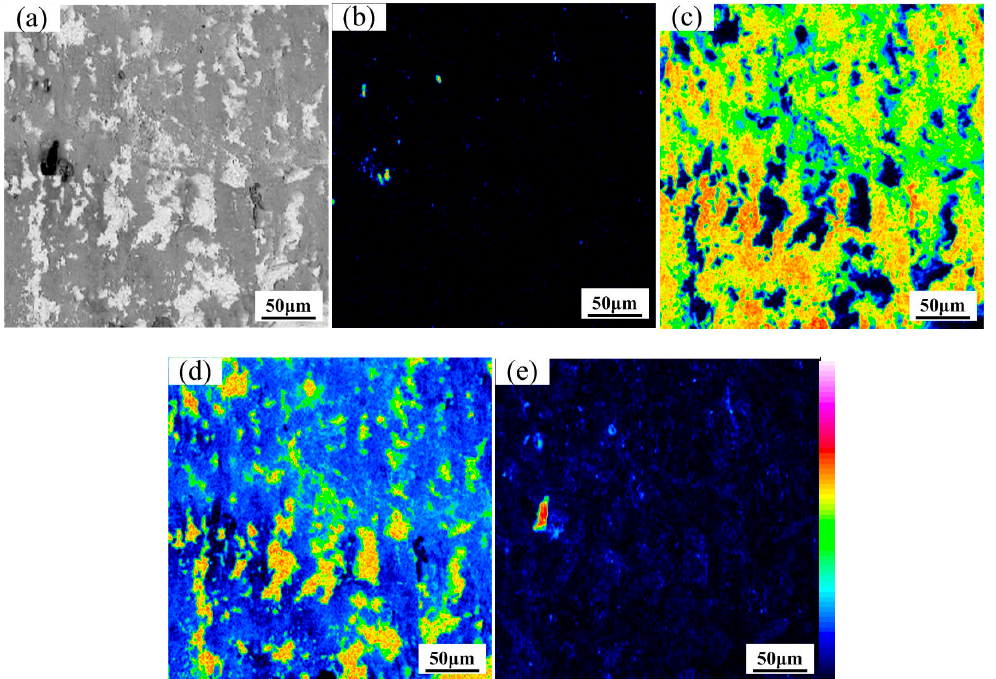
Figure 9. Map distribution micrographs of various elements on the fractural surface of Ti/Nb/steel clad plate at 900 °C (titanium side): ( a ) BSE image; ( b ) Fe element; ( c ) Ti element; ( d ) Nb element and ( e ) C element.